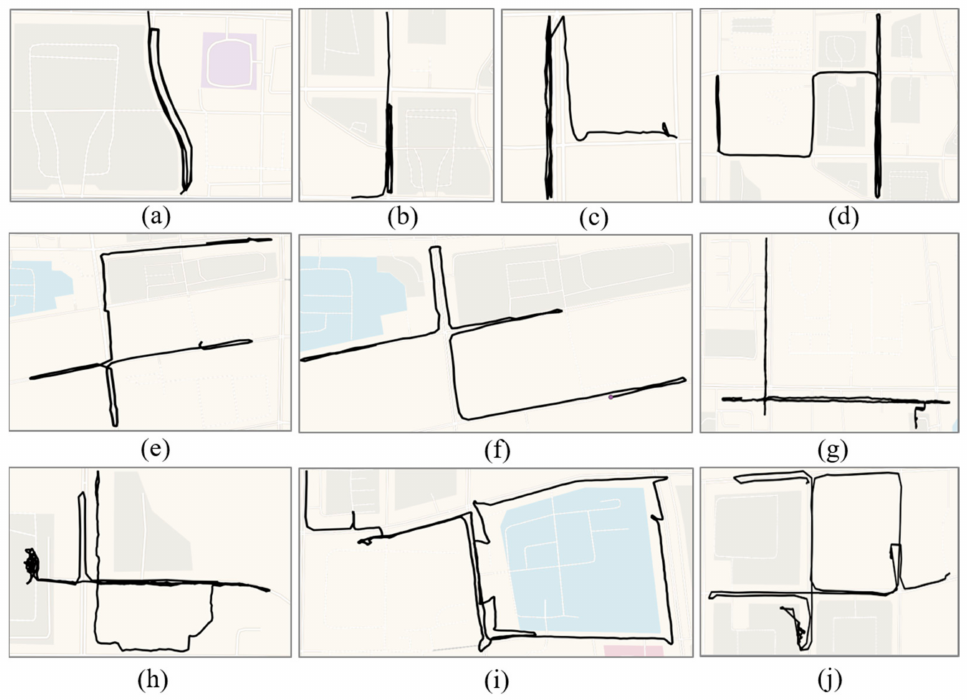
Figure 10. Examples of the trajectories of aimlessly wandering in the TucityLife dataset. Aimlessly wandering on the same road ( a – d ), on different roads ( e – h ), and in an area ( i , j